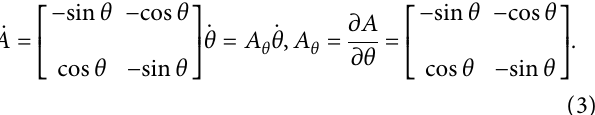
Figure 2: Computational domain of a 5MW scale wind turbine.